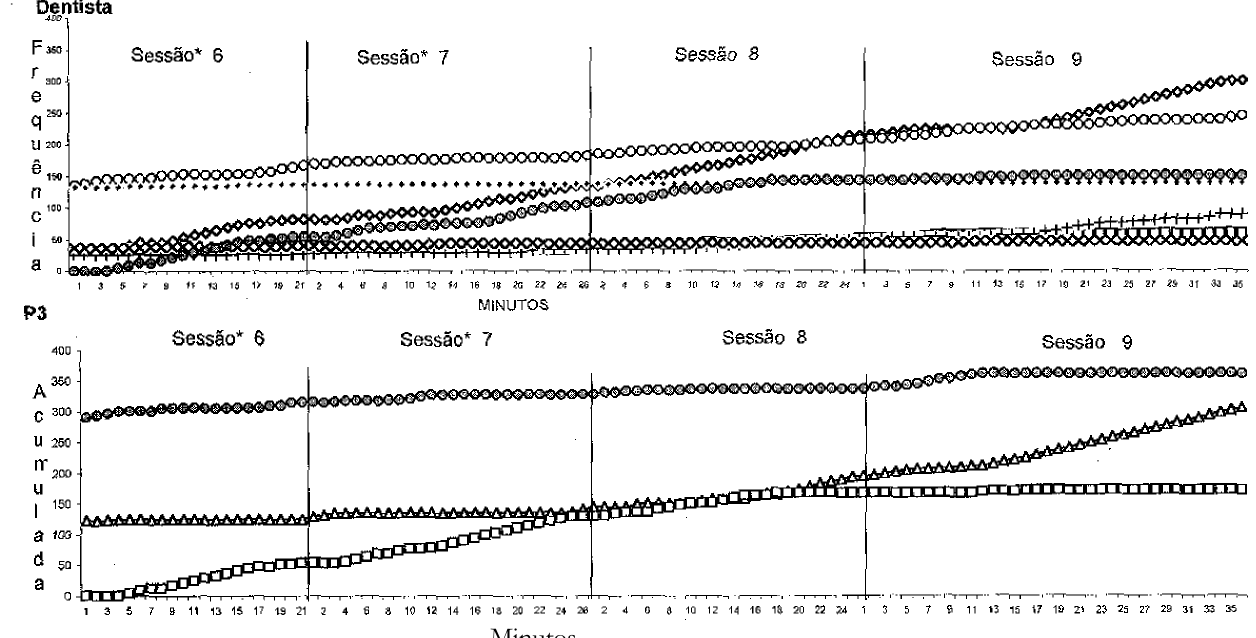
Figura 2. Freq(cid:252)Œncia acumulada das categorias de comportamento da dentista e do P3 da sexta e nona sessıes de atendimento. As categorias do dentista foram: Realiza Atividade, Dire(cid:231)ªo, Tranq(cid:252)iliza(cid:231)ªo, Distra(cid:231)ªo, Persuasªo, Puni(cid:231)ªo Verbal e Restri(cid:231)ªo F(cid:237)sica para o tratamento odontol(cid:243)gico. Para o P3 as categorias foram: Colabora(cid:231)ªo, Colabora(cid:231)ªo sob Restri(cid:231)ªo F(cid:237)sica e Nªo Colabora(cid:231)ªo. Nas sessıes com aster(cid:237)scos a crian(cid:231)a tinha recebido 0,3mg de Diazepam por Kg de peso.